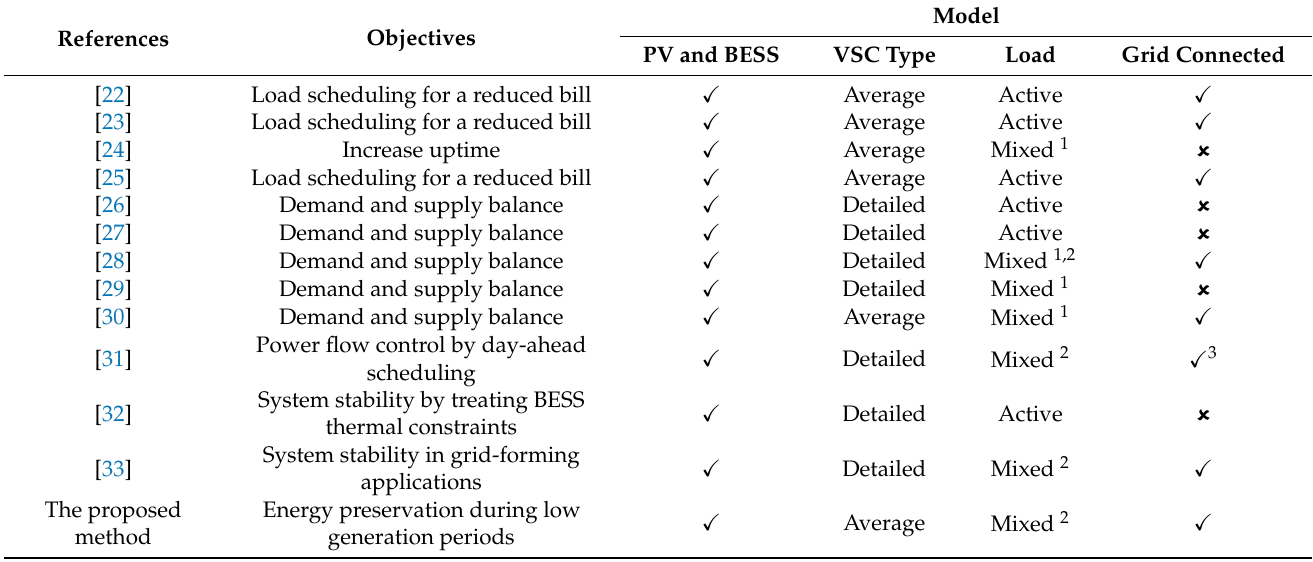
Table 1. Summary of Related Works: Objectives and model.